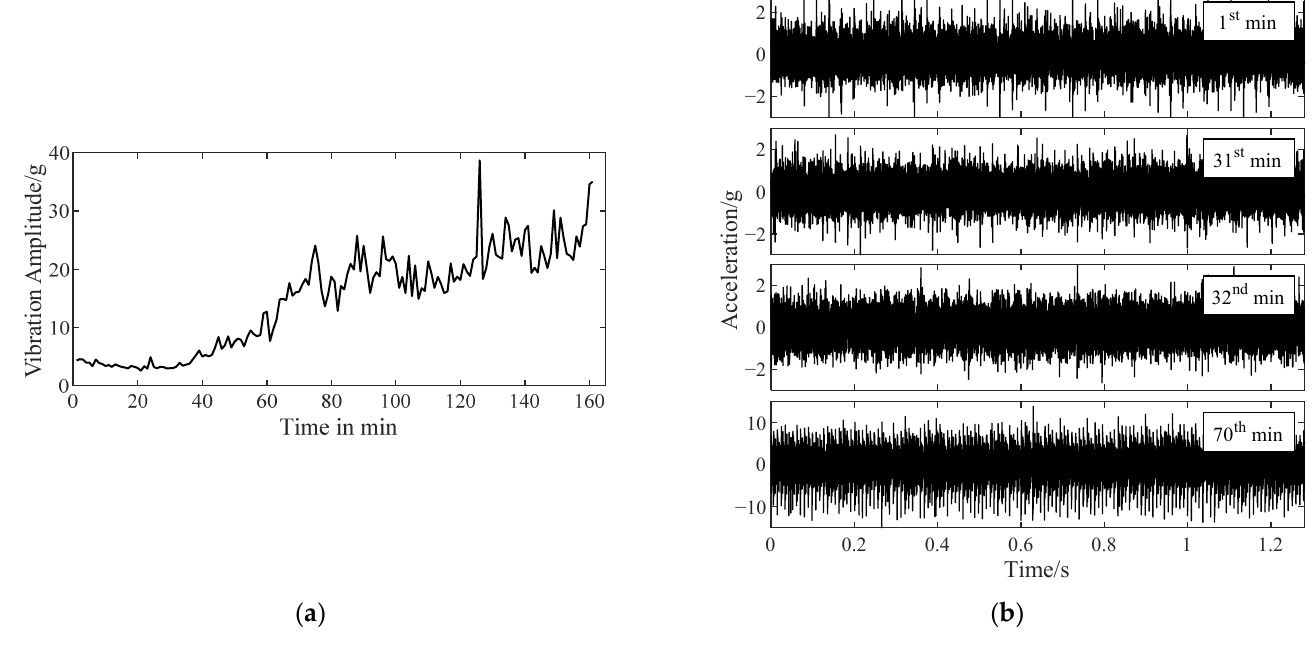
Figure 5. Vibration data of bearing 1 with a developing outer ring fault. ( a ) The curve of maximum vibration amplitude versus time; ( b ) vibration signals measured at 1st/31st/32nd/70th min.